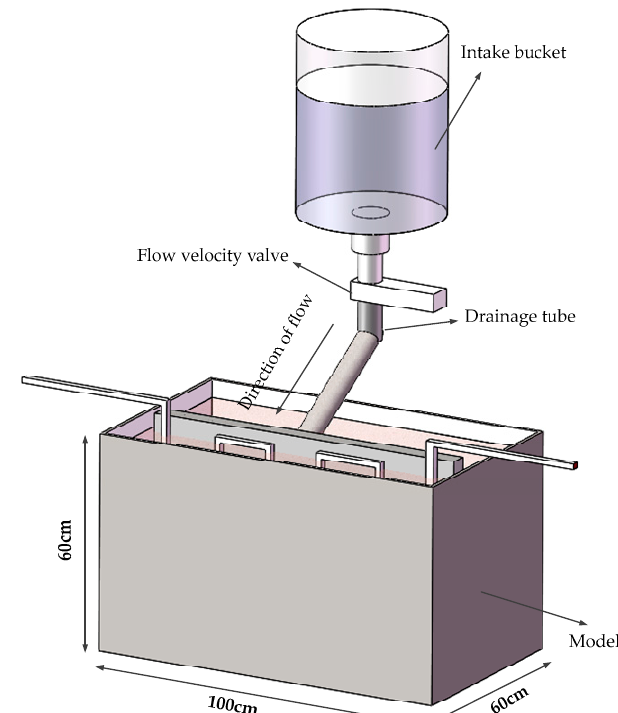
Figure 3. Heating cable and fiber diagram. Sensors 2019 , 19 , x FOR PEER REVIEW